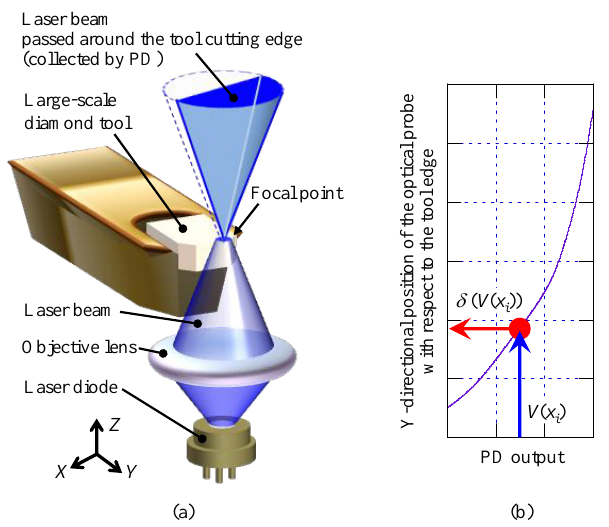
Figure 1. Schematic of the proposed micro optical probe. (a) Con-